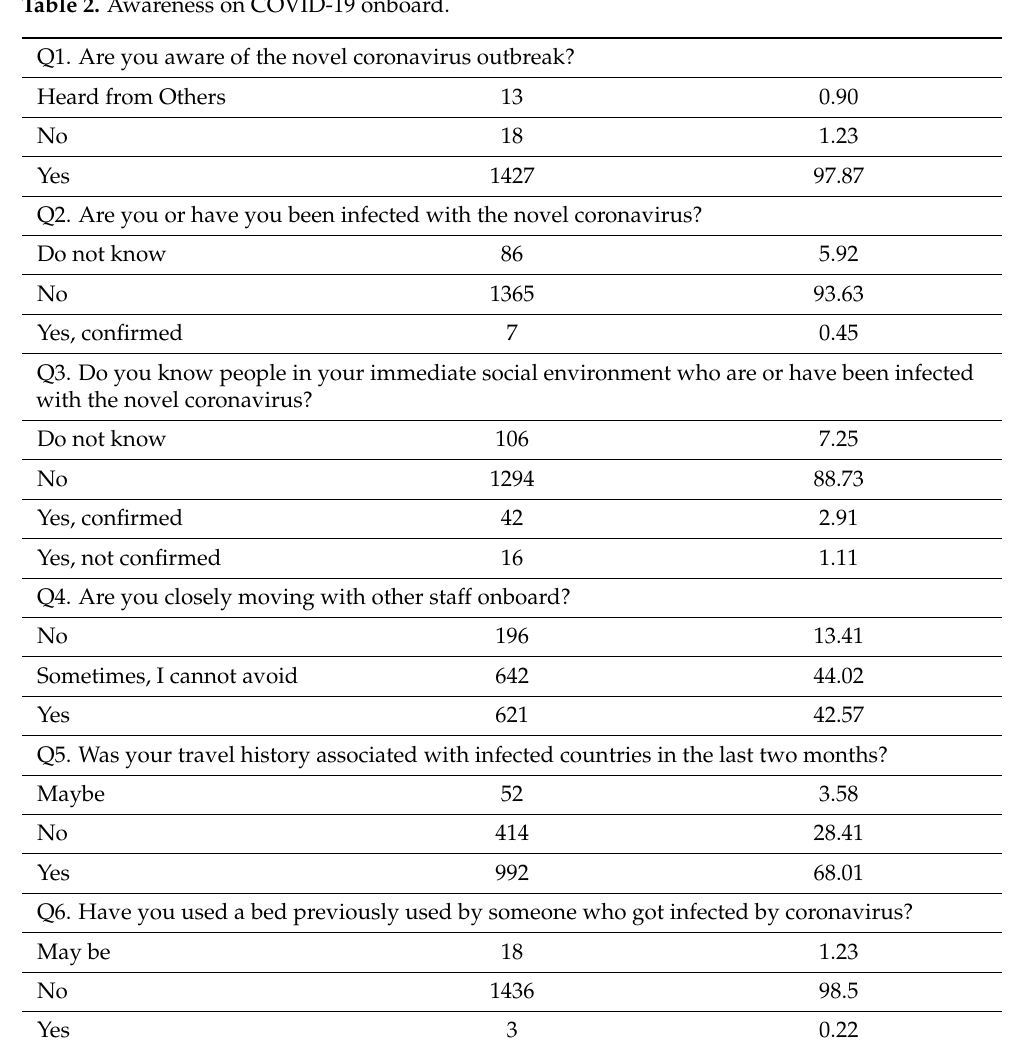
Table 2. Awareness on COVID-19